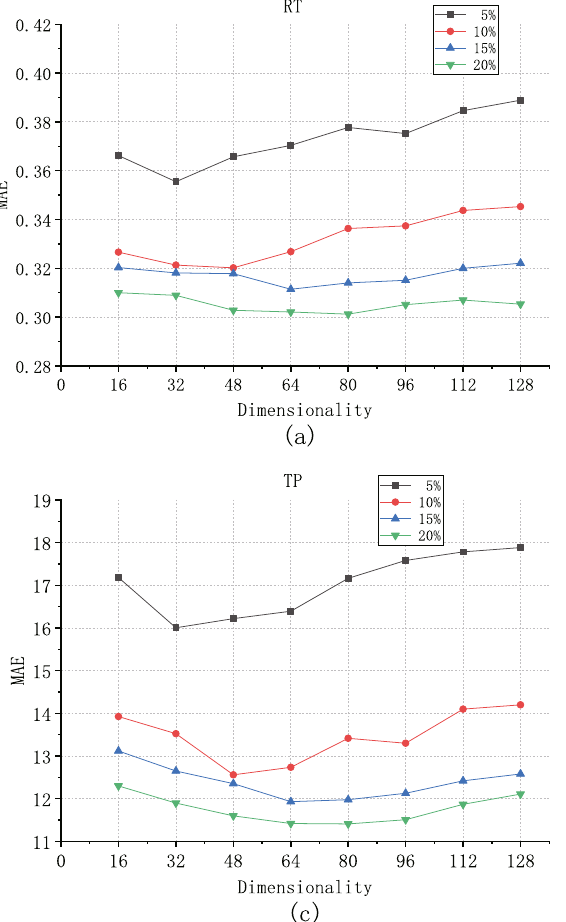
Fig. 7 Impact of Dimensionality in Embedding Layer